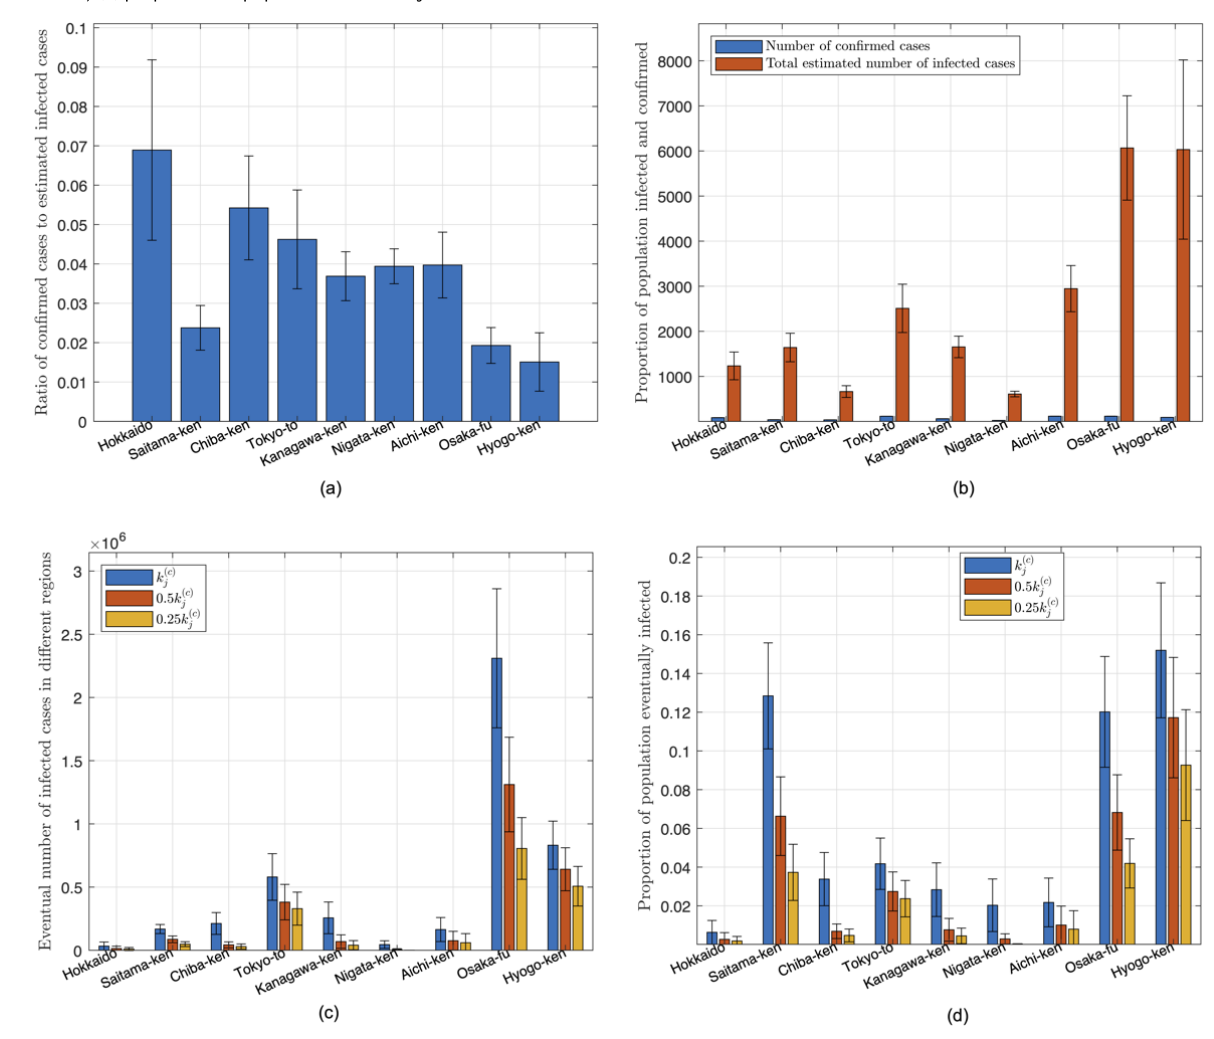
Figure 3. Statistics of data and predicted results for Japan. (a) Proportion of infected cases that are confirmed as of March 20, 2020; (b) number of confirmed cases and estimated number of infected cases as of March 20, 2020; (c) number of individuals eventually infected under three levels of active intervention; (d) proportion of population eventually infected under three levels of active